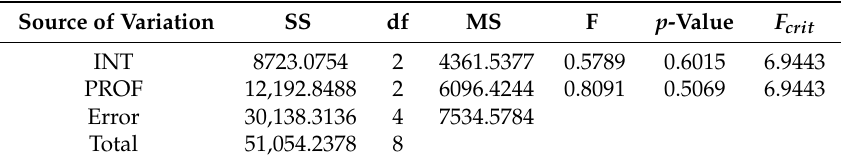
Table 7. Analysis of variance (ANOVA) table for the ethanol productivity, using the GA as the optimization algorithm. The terms SS, df, MS represent the summation of the squared variations, number of degrees of freedom and mean squared variation, respectively.